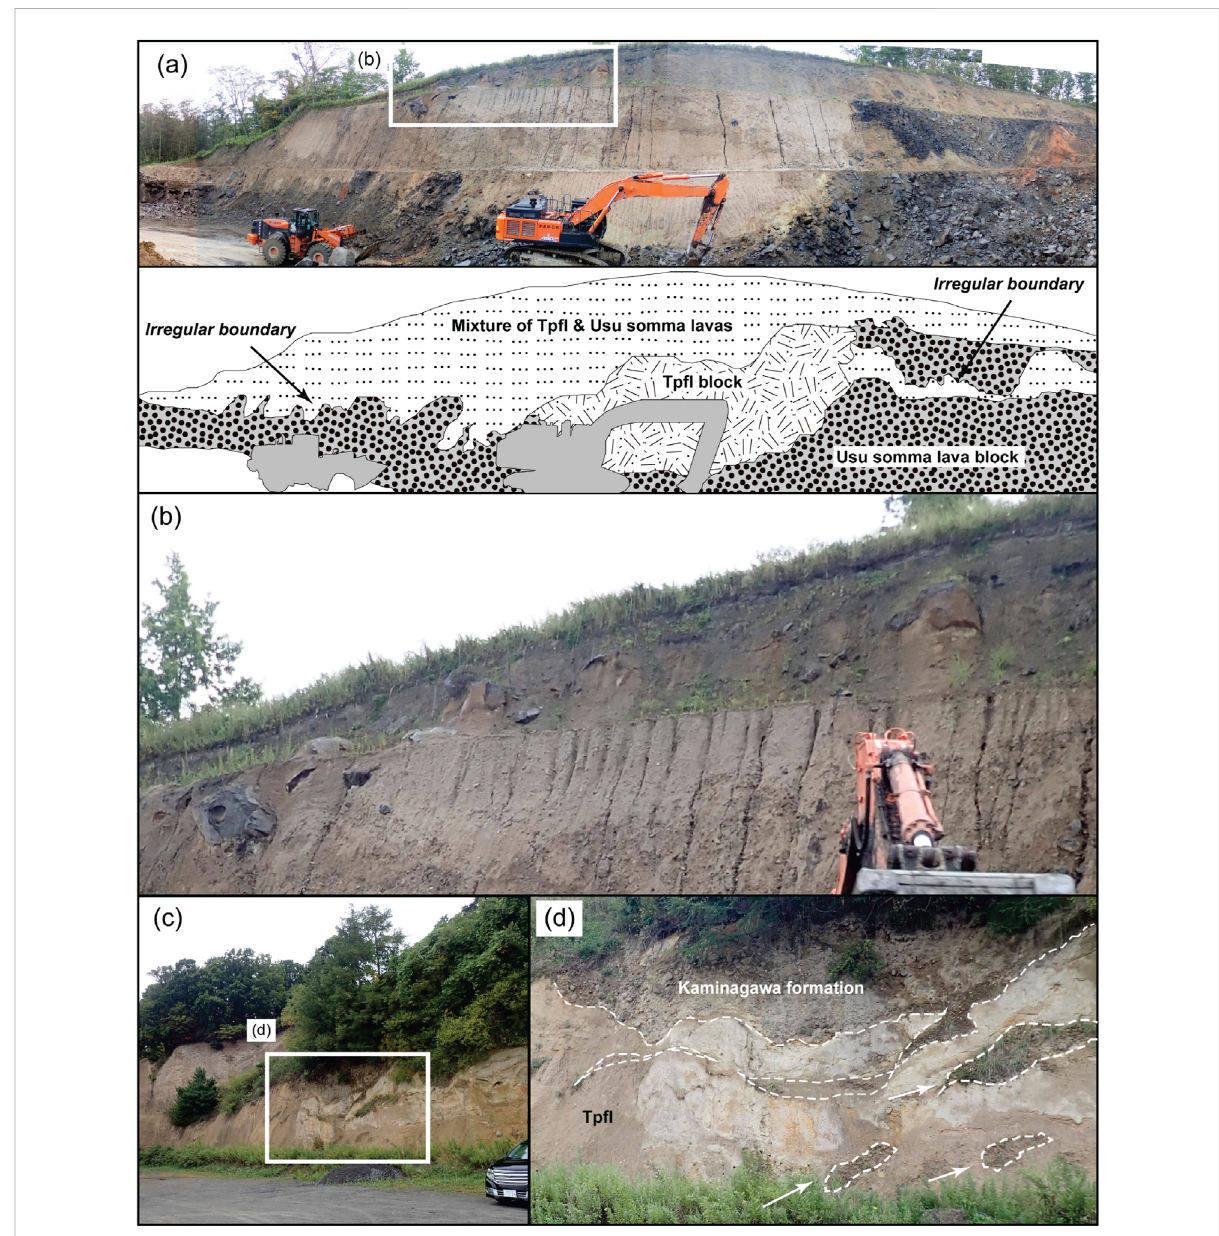
FIGURE 5 Photographs of Zenkoji debris avalanche (ZDA) deposit hummocks. (A) Cross-section of a hummock at loc. C. The Usu somma lava block occursatthebaseandisoverlain byaToyapyroclastic fl ow(Tp fl )block. Theboundarybetween bothisirregularandoftenshows fl ame structures. A mixed facies of Usu somma lava and Tp fl fragments occurs at the top. (B) The mixed facies. The Tp fl deposit is dominant in the facies and is fragmentedandmixedwithdisintegratedUsusommalavaclasts. (C) Cross-sectionofahummockatloc.D. (D) ThehummockcomprisesaTp fl blockatthebaseandtheKaminagawaFormationatthetop.Theboundaryisirregular.TheKaminagawaFormationisdeformedandintrudesintothe Tp fl